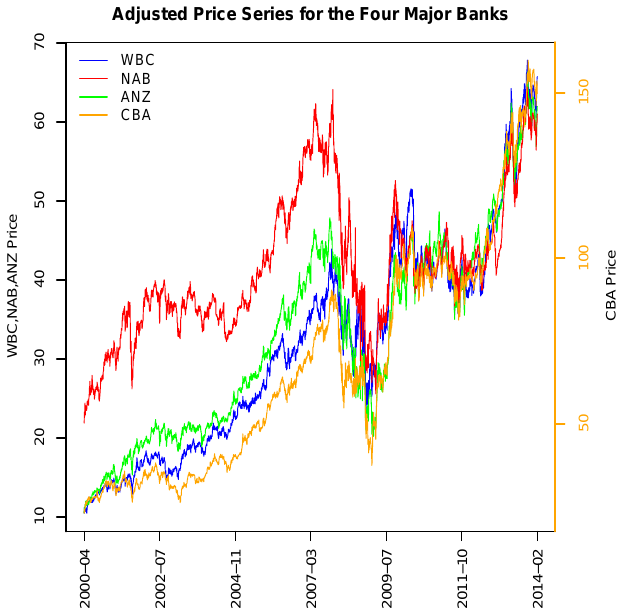
Figure 7. Time series plots of near-linear correlated stocks identified in the scatter plots of components 153 to 156: the four big banks in Australia. ANZ (ANZ), Commonwealth Bank of Australia (CBA), National Australia Bank (NAB) and Westpac (WBC).